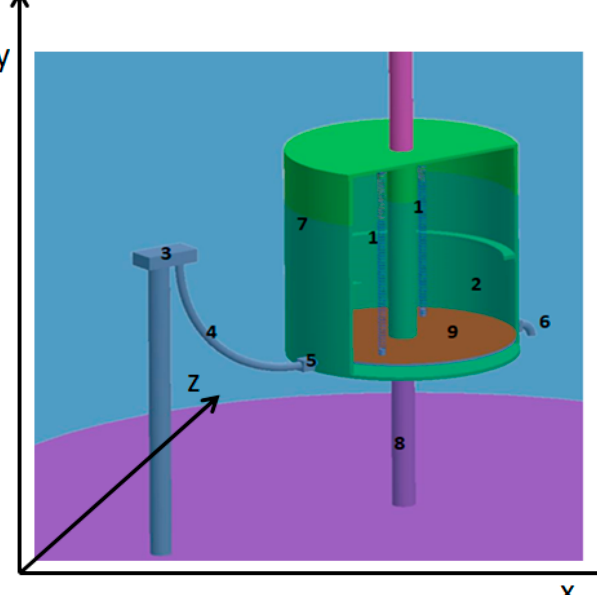
Figure 1. The conceptual design of the self-adjusted WEC with main components: 1. Cable / spring; 2. WEC chamber; 3. wave period measuring device and inlet valve to allow seawater flow into the flexible pipe through gravity; 4. flexible pipe; 5. WEC chamber inlet; 6. WEC chamber outlet; 7. WEC buoy; 8. frame; and 9. plate / diaphragm.